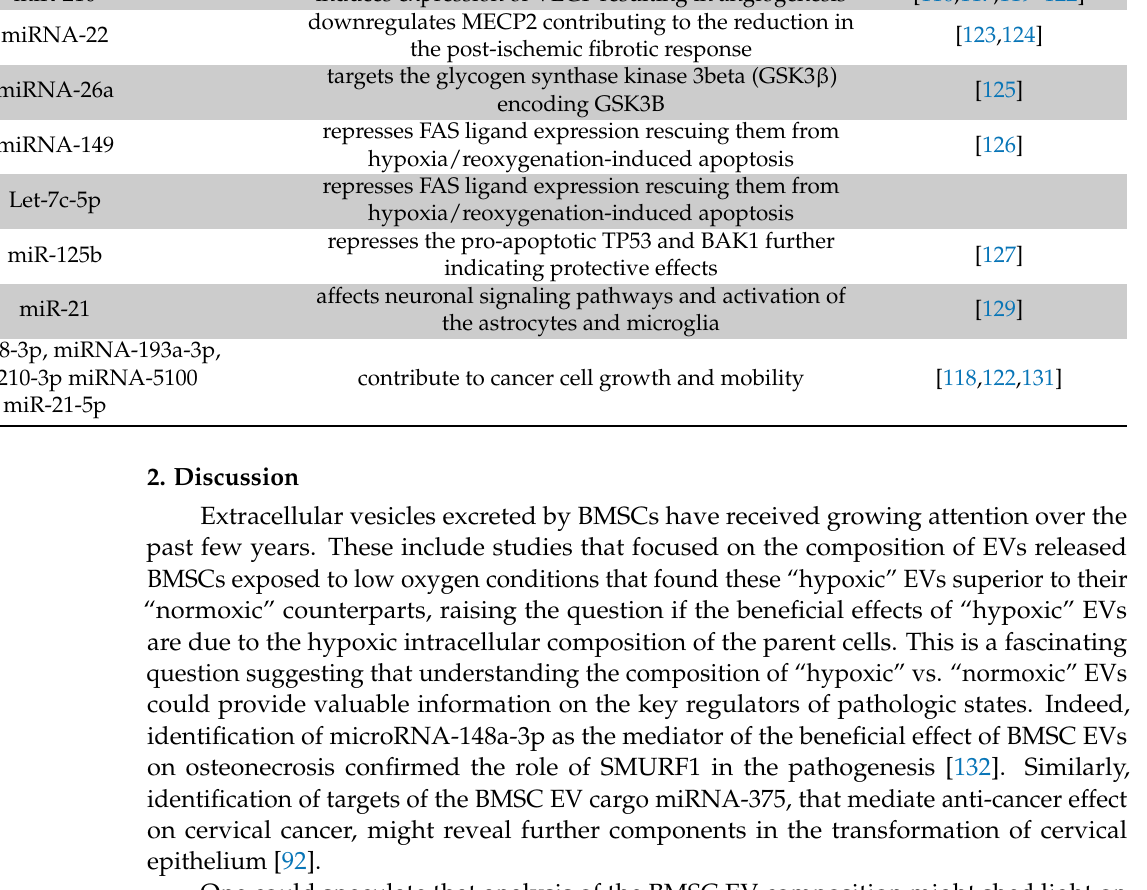
Table 1. Summary of the cargo molecules enriched in EVs released from hypoxic BMSCs. Hypoxic EV Payload Observed